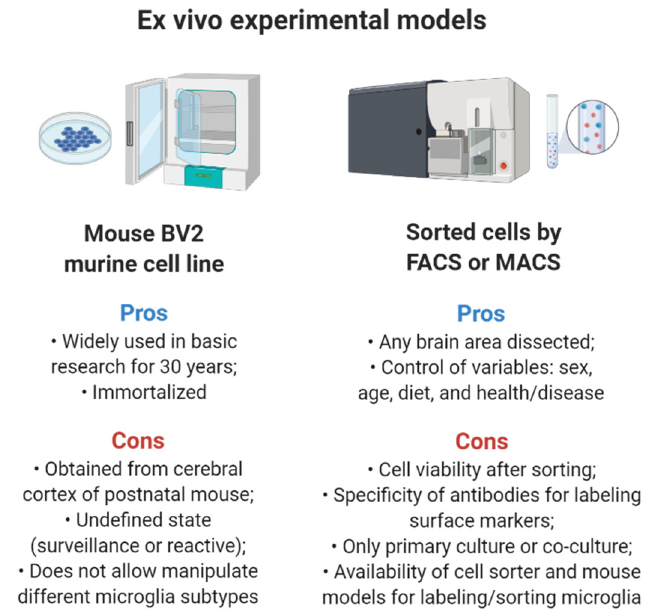
Figure 3. Comparisons between ex vivo experimental models for studying cultured microglia. Pros (in blue) and Cons (in red) of each approach are depicted in figure. Abbreviations: FACS, fluorescence-associated cell sorting; MACS, magnetic-activated cell sorting.